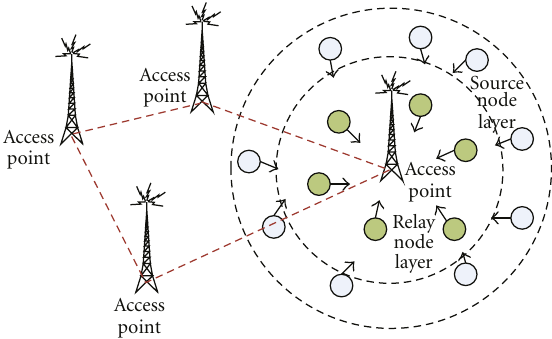
Figure 1: Hierarchical communication structure with multiple sources and dedicated relays.